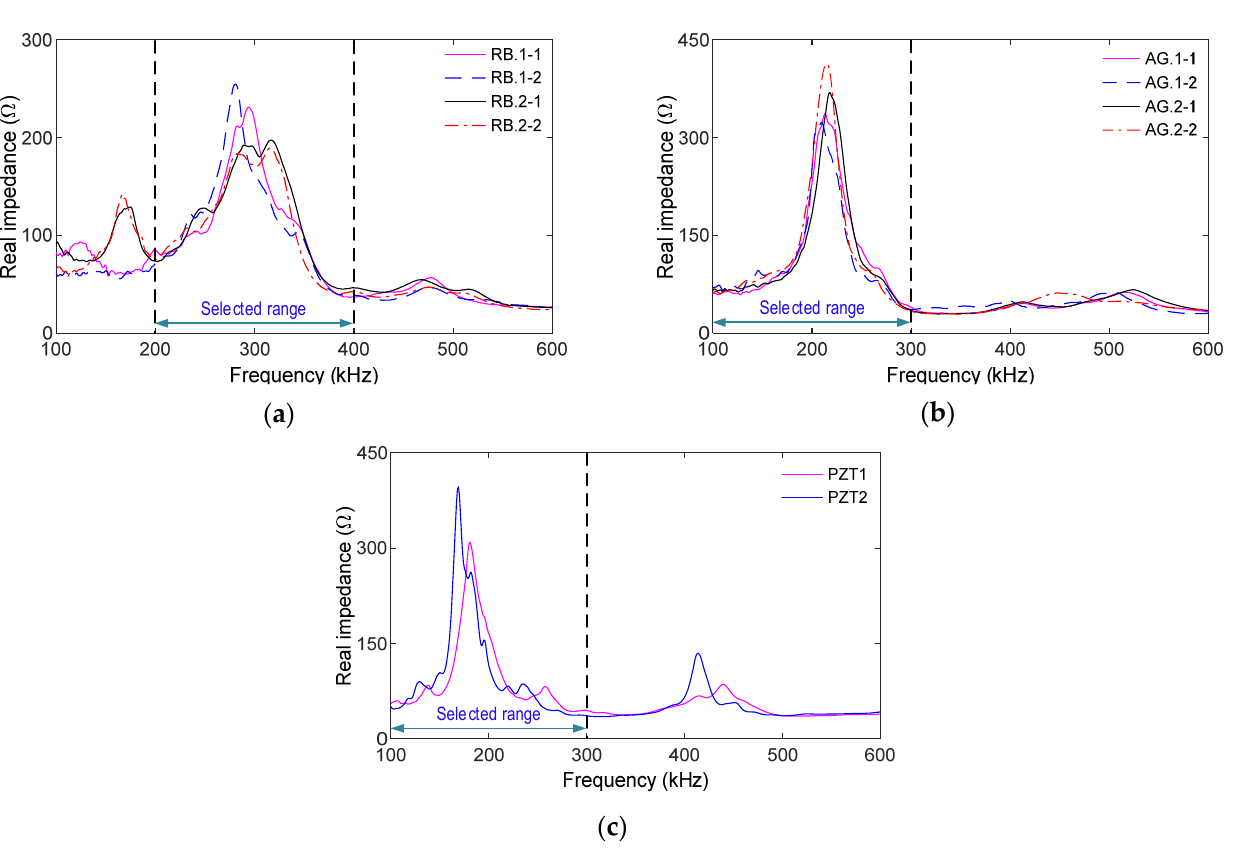
Figure 18. Impedance responses of PZT-embedded sensors for intact case (PS1): ( a ) PZT-embedded smart rebar; ( b ) PZT-embedded smart aggregate; ( c ) Surface-bonded PZT sensor.